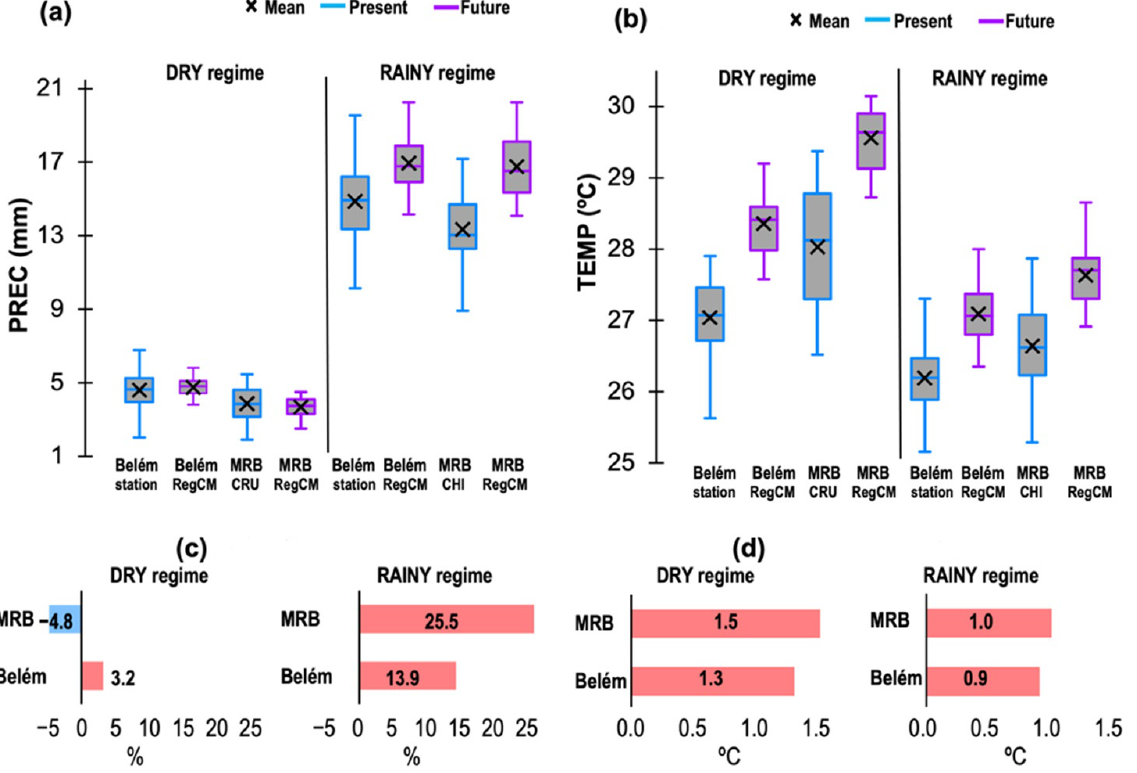
Figure 12. Boxplots of present (1985/2020) and future (2021/2045) climate considering the RAINY and DRY regime for ( a ) PREC; ( b ) TEMP. Changes in the future relative to the present for ( c ) PREC (%); ( d ) TEMP (°C).